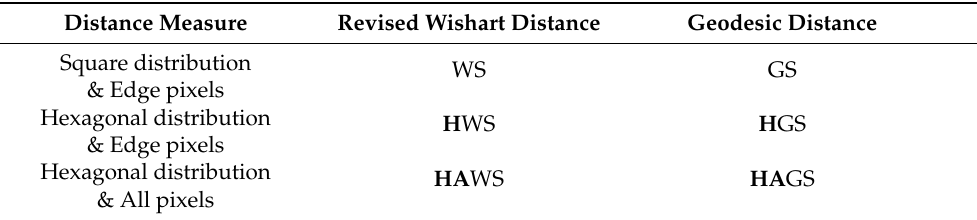
Table 1. Algorithms used to verify the initialization